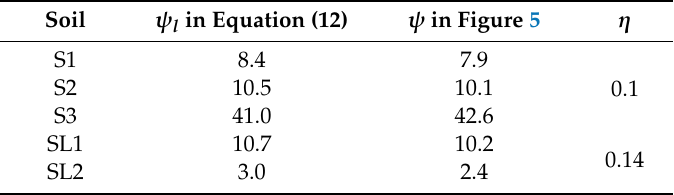
Table 3. The water entry suction for homogeneous soils in Equation (12) and in Figure 5 when the buried depth of sand layer is equal to 0, and parameter η for the two infiltration experiments.